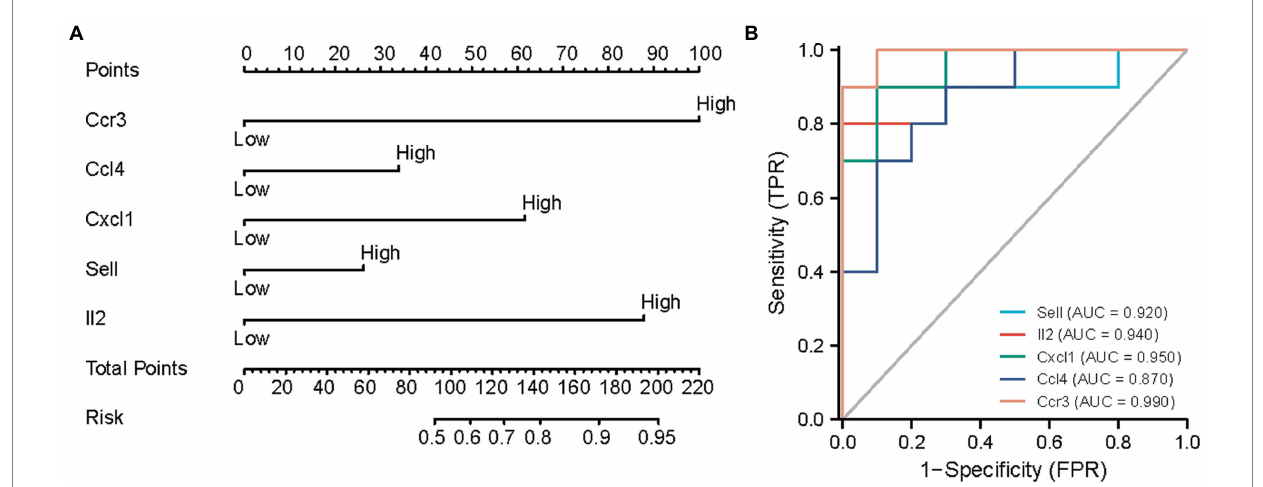
FIGURE 5 Predicting the risk of neuropathic pain using nomograms. (A) Nomogram model of hub genes. (B) ROC curves to assess the diagnostic efficacy of nomogram model and each hub gene.